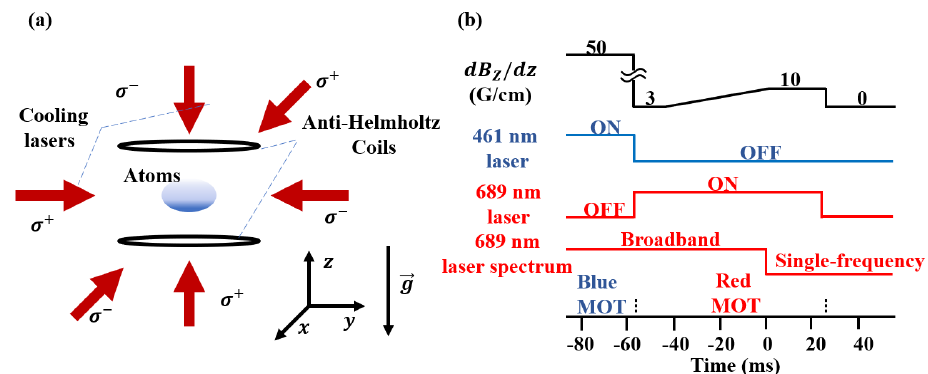
Figure 1. Schematic of a typical MOT (magneto-optical trap) of 88 Sr for a ground-based experiment. ( a ) MOT configuration and ( b ) time